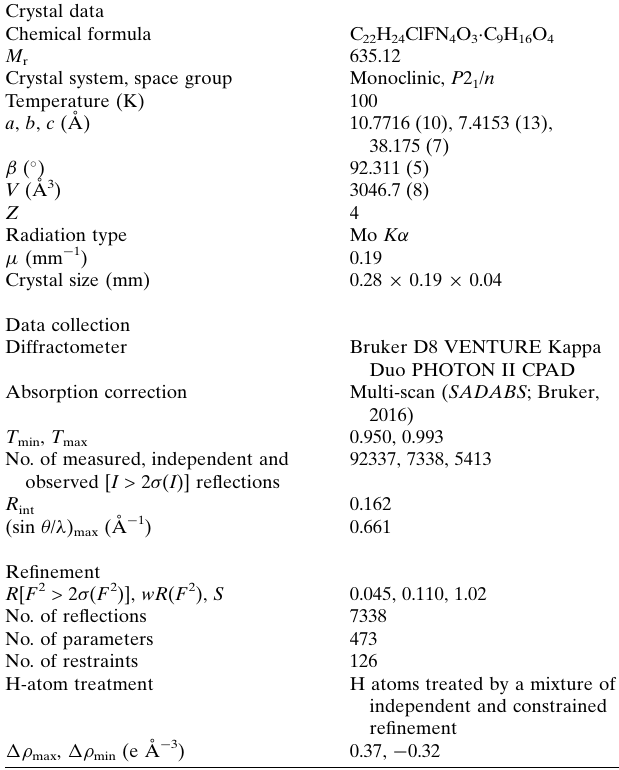
Crystal data Chemical